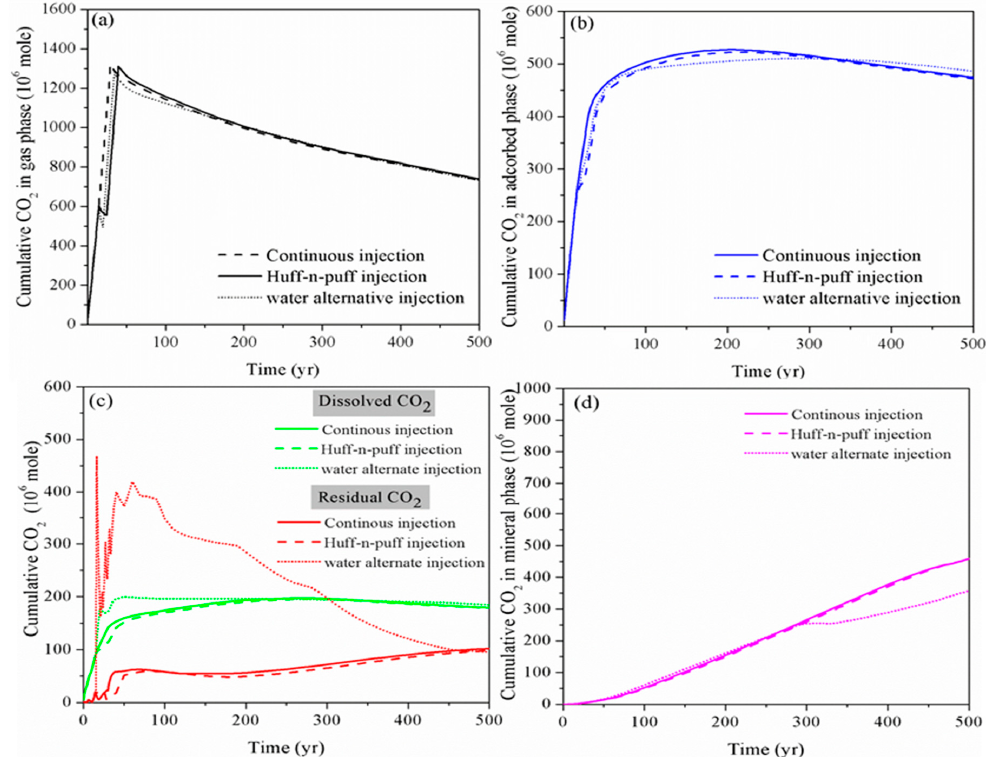
Figure 7. Cumulative CO 2 storage in different storage mechanisms using various CO 2 injection schemes. ( a ): gas phase;( b ): adsorbed phase; ( c ): dissolved and residual phase; ( d ): mineral phase)